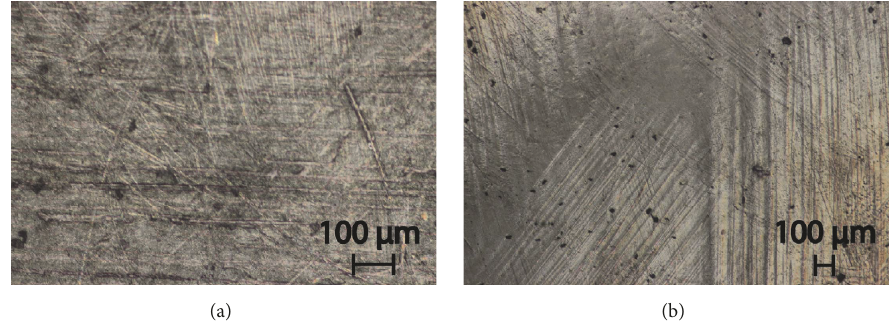
Figure 1: Microscopic photographs of (a) the proposed CFRP with fiber shreds in random alignment on top and (b) the twill-weave CFRP reference material. The unidirectional filaments are visible underneath the fiber shreds as horizontal